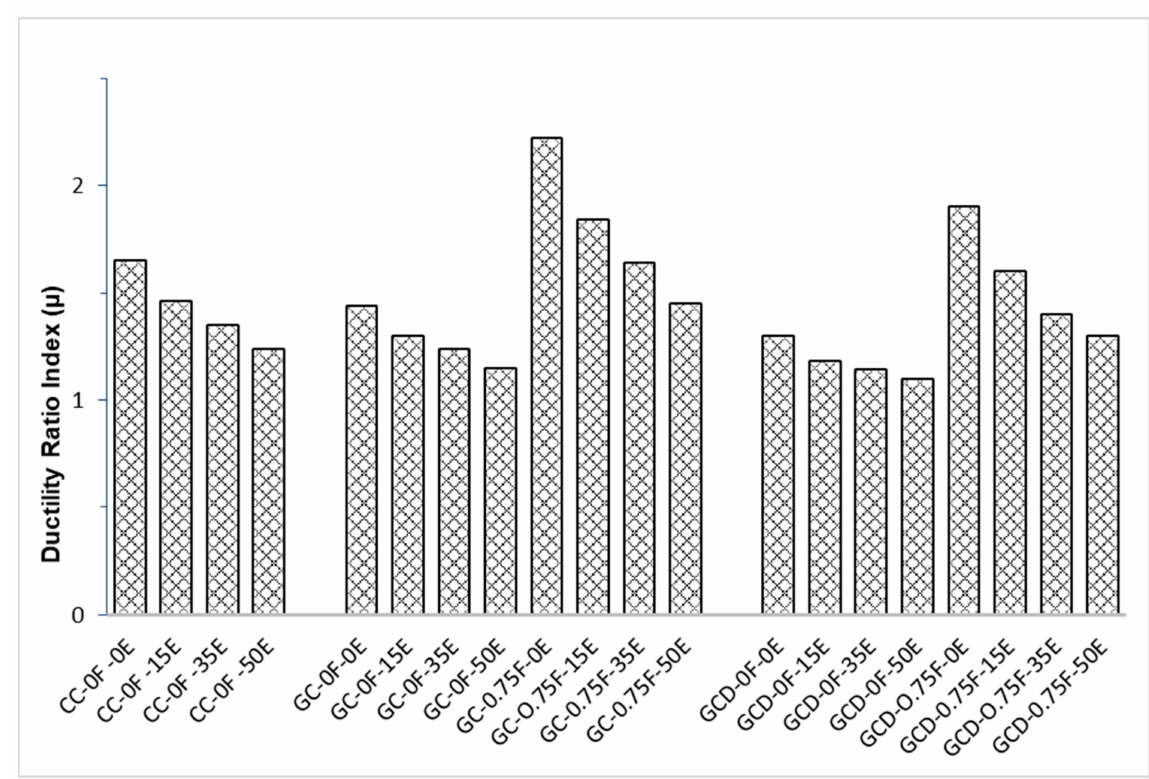
Figure 15. The ductility index of CC, GC, and GCD